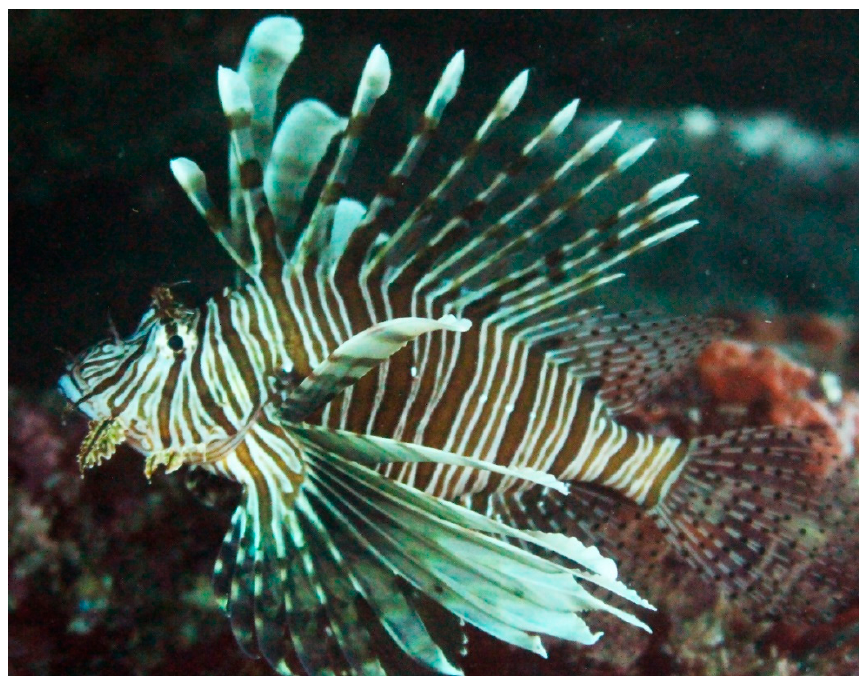
Figure 1. A lionfish ( Pterois miles ) individual photographed at the reefs of the Cavo Greco (Cyprus) Marine Protected Area in May 2019.